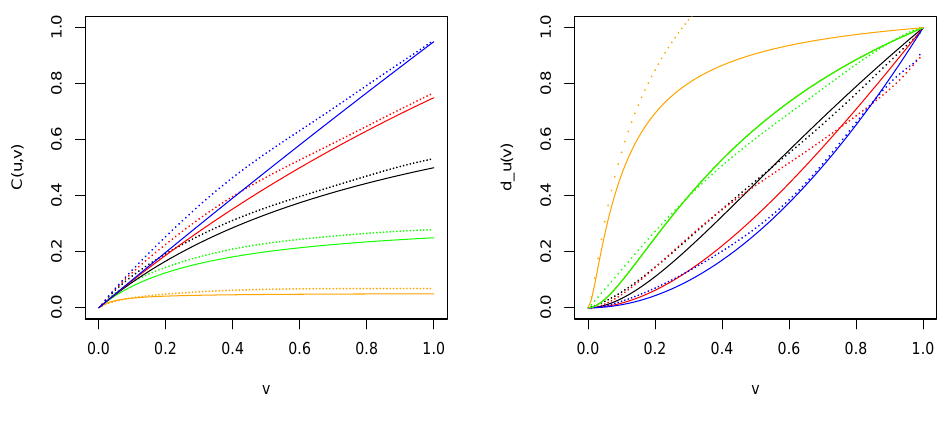
Figure 13: Kernel estimations (left) of the copula C ( u , v ) in Example 2.2 for u = 0.05, 0.25, 0.5, 0.75, 0.95 (dotted lines from the bottom). The respective estimations for d u ( v ) obtained from eq. (3.2) are potted in the right. The continuous lines represent the exact